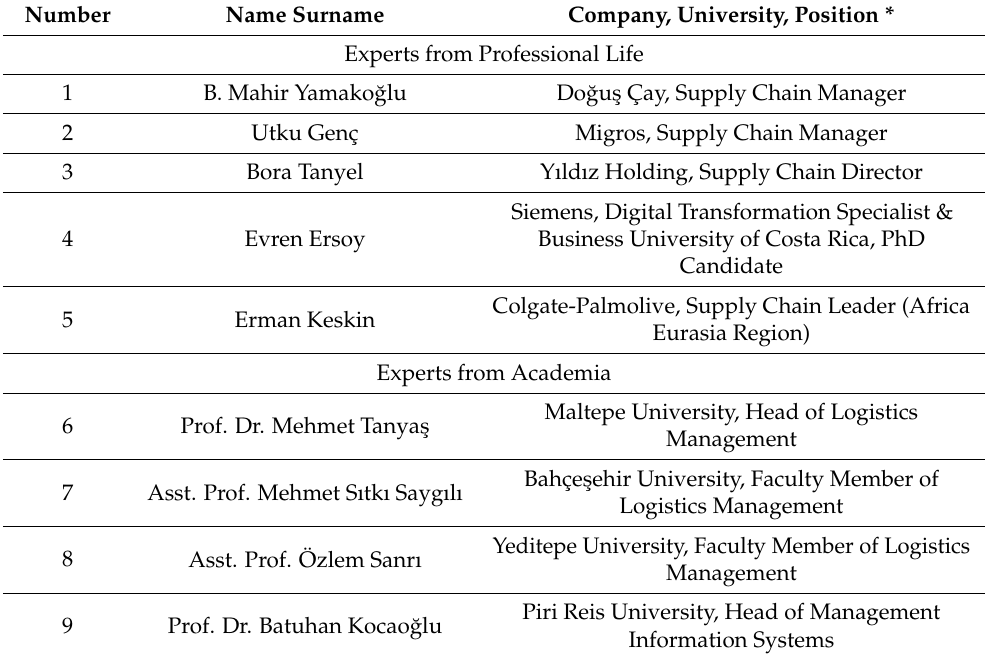
Table A1. List of Expert Group.